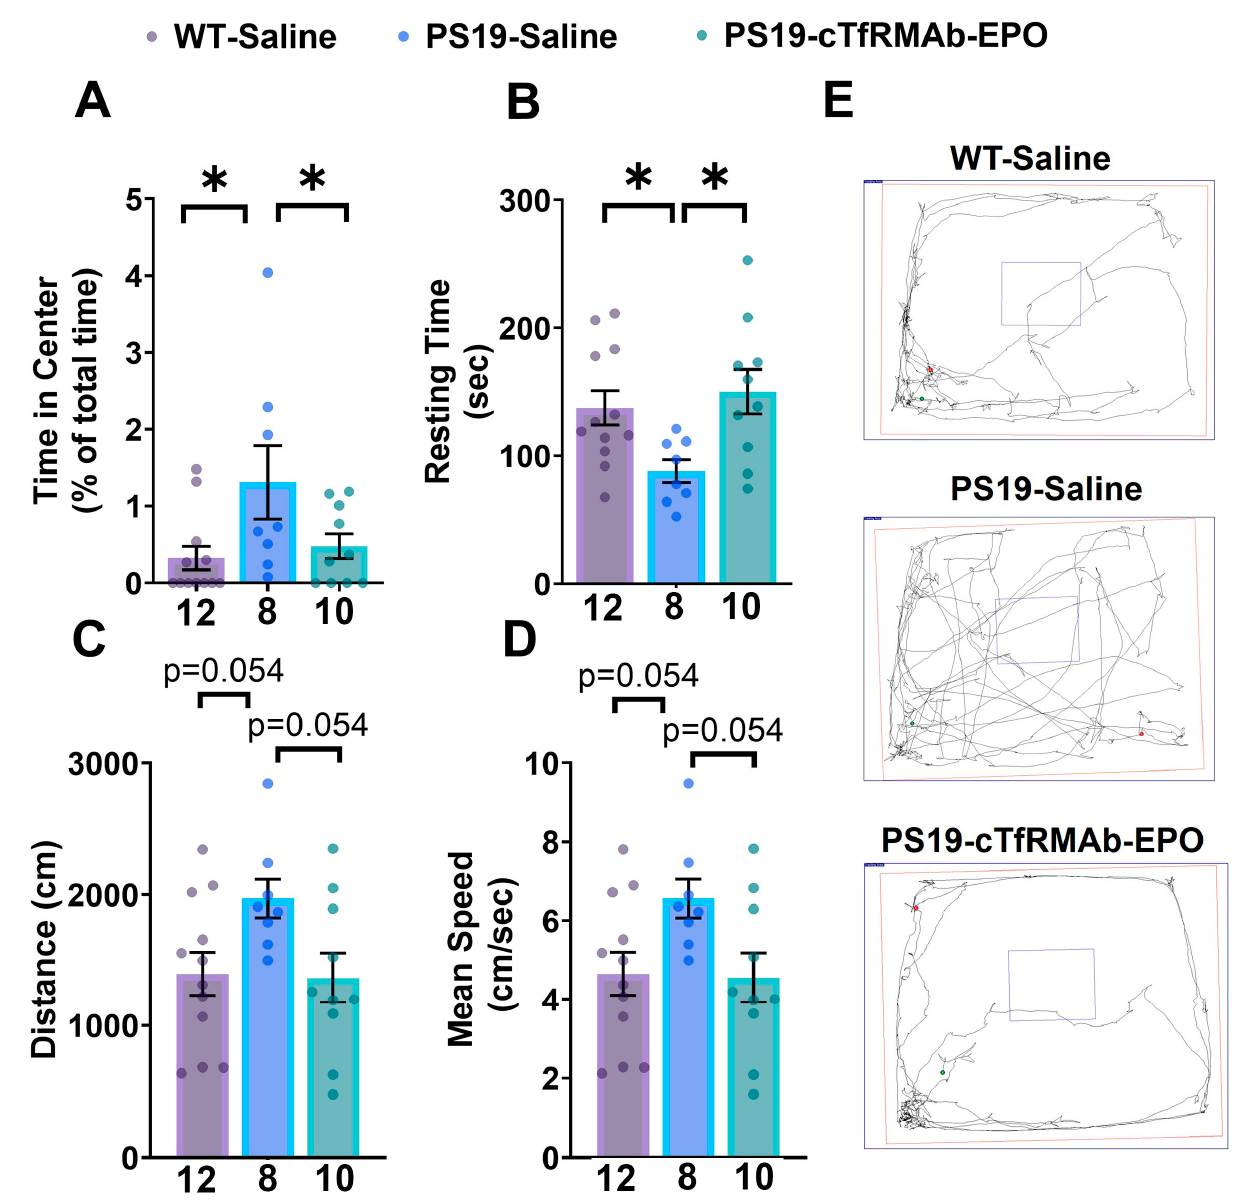
Figure 1. Effect of cTfRMAb-EPO on anxiety and hyperactivity in the PS19 mice. ( A ) The saline- treated PS19 mice spent more time in the center, ( B ) had reduced resting time, and ( C ) trended towards a higher distance traveled and ( D ) overall mean speed compared to the saline-treated WT mice during open-field testing. Chronic cTfRMAb-EPO treatment prevented these altered behaviors in the PS19 mice. ( E ) Representative trajectory maps showing the movement of the WT and PS19 mice. One outlier was excluded from the PS19-Saline group. One-way ANOVA with Holm–Sidak’s post hoc test was used to compare to the PS19-Saline mice. Data are shown as mean ± SEM of n = 8–12 per group (shown below each column). * p < 0.05 compared to PS19-saline.